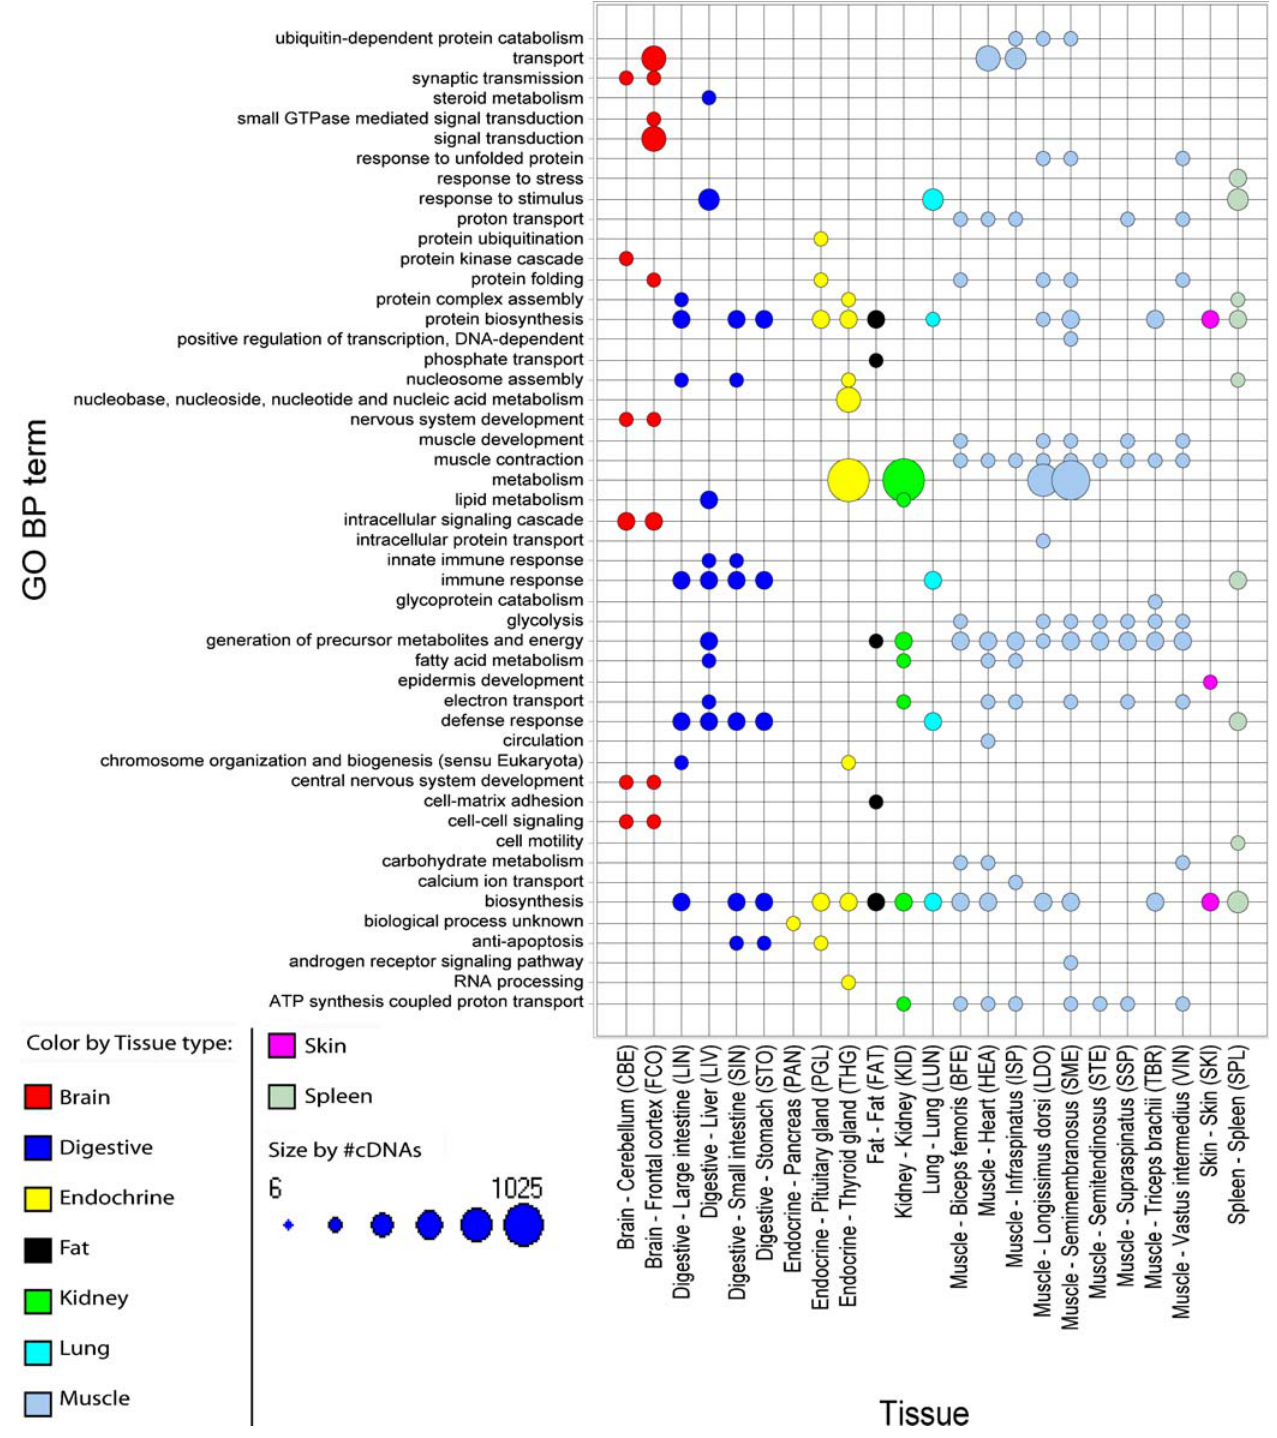
Figure 1. Enriched GO BP terms for cDNAs representing positively regulated genes. Size of dots corresponds to the number of cDNAs that were tested (minimum=6 and maximum=1025) and color codes indicate tissue type. Only significant (P # 0.01) GO-BP terms represented by 50 or more cDNAs on the array were included.